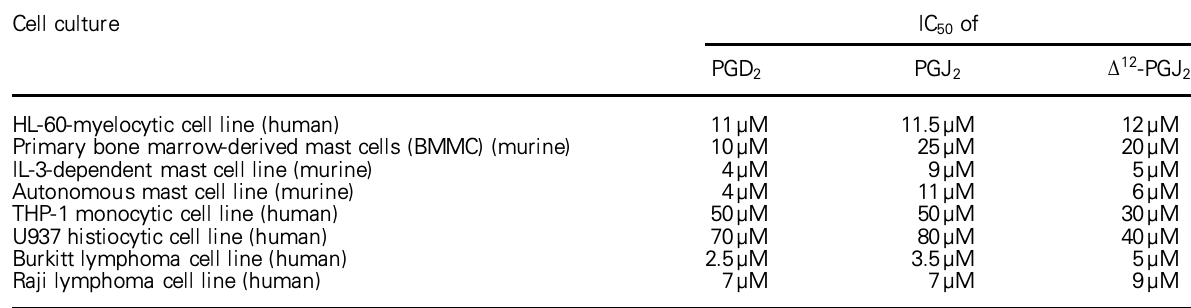
Table 1. Concentrations of PGD 2 , PGJ 2 and D 12 -PGJ 2 required for 50% inhibition of cell proliferation (IC 50 ) in selected cell lines ( n = 4) Cell